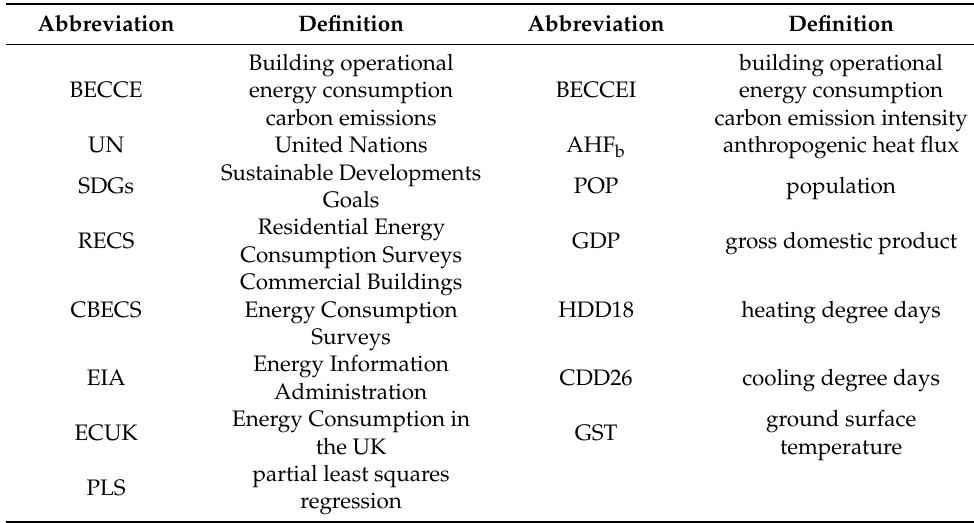
Table A1. Abbreviations in this